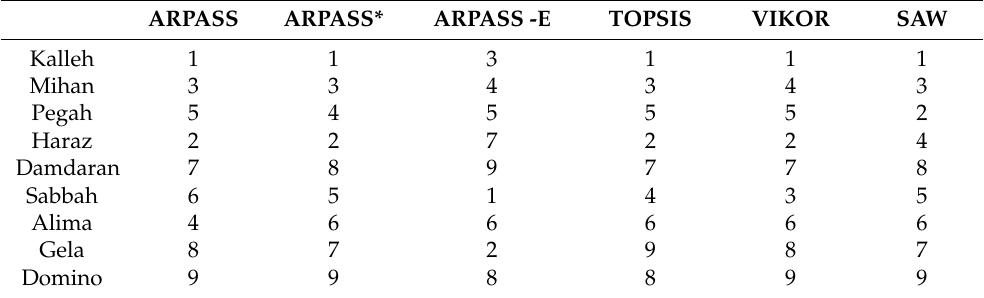
Table 22. The ranking results in ARPASS, TOPSIS, SAW, VIKOR, and ARPASS* methods where ARPASS-E.